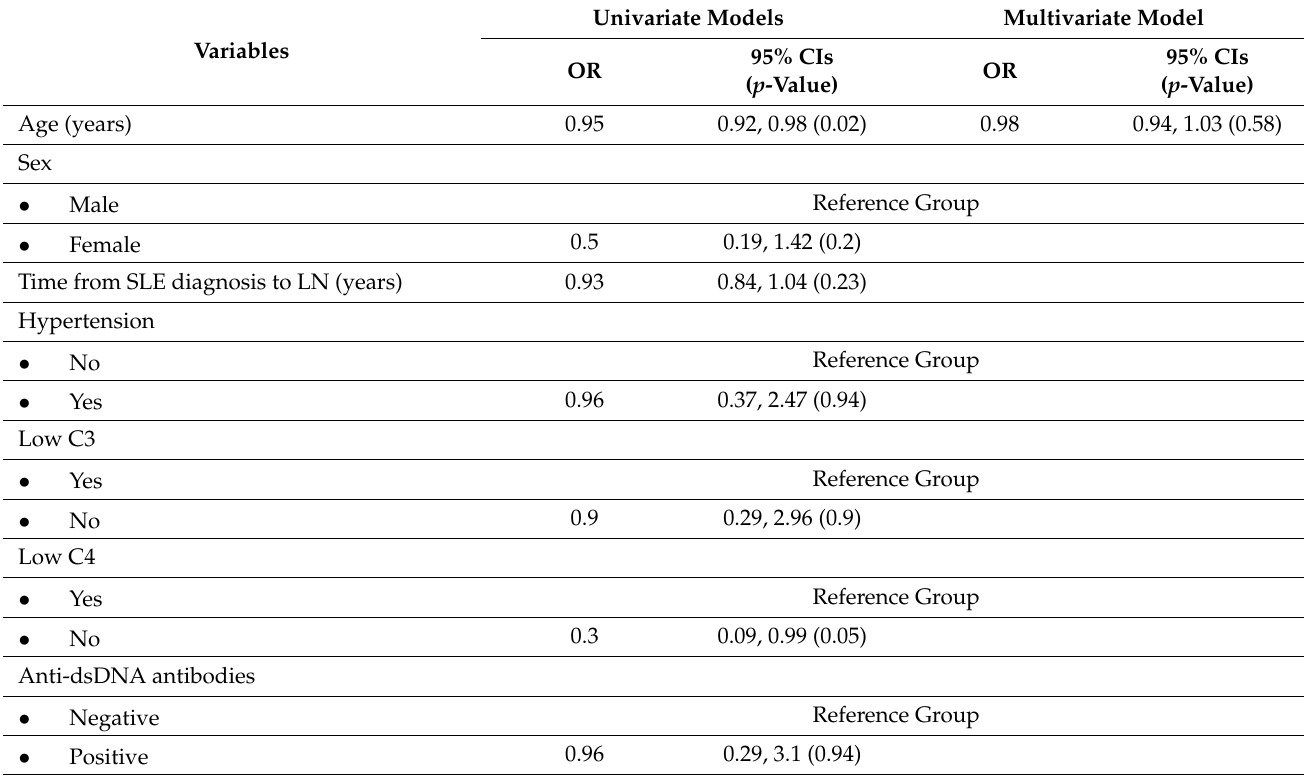
Table 3. Predictors of